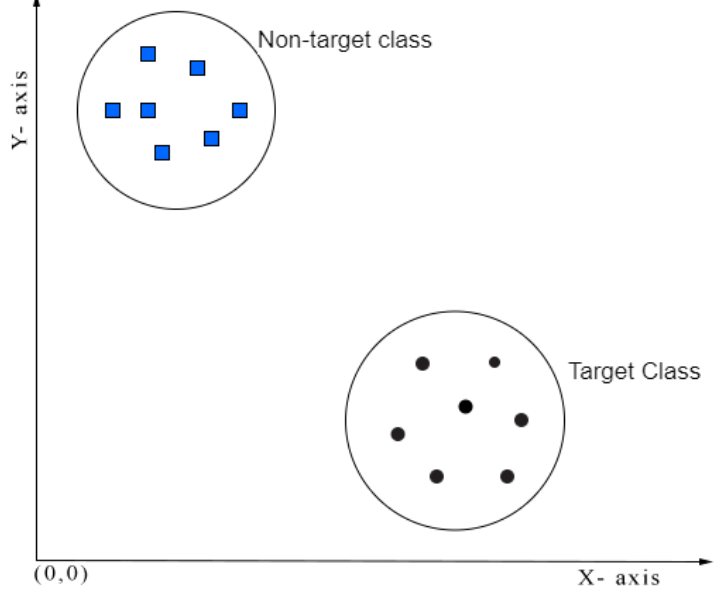
Figure 1. Representation of dataset contains datapoints target class and non-target class.